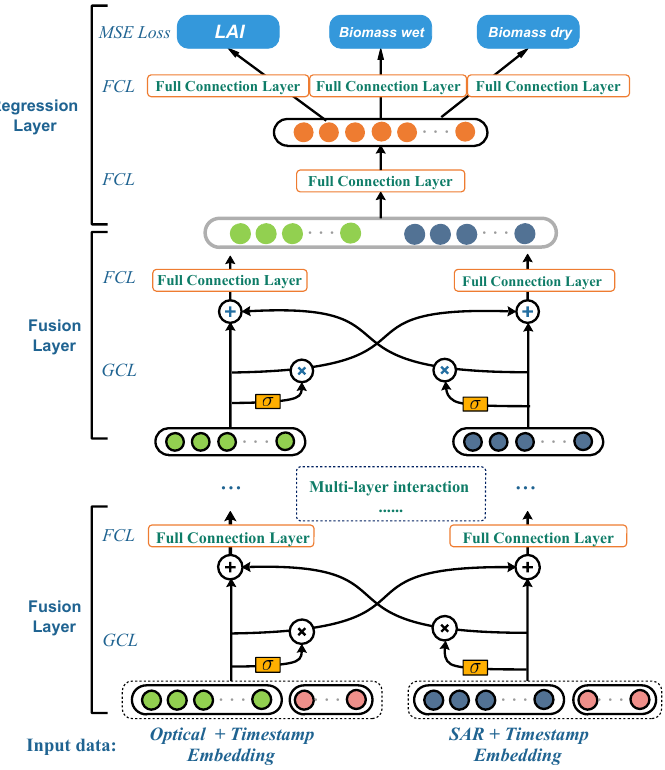
Figure 2. Gated Siamese Deep Neural Network(GSDNN) architecture for maize LAI and biomass